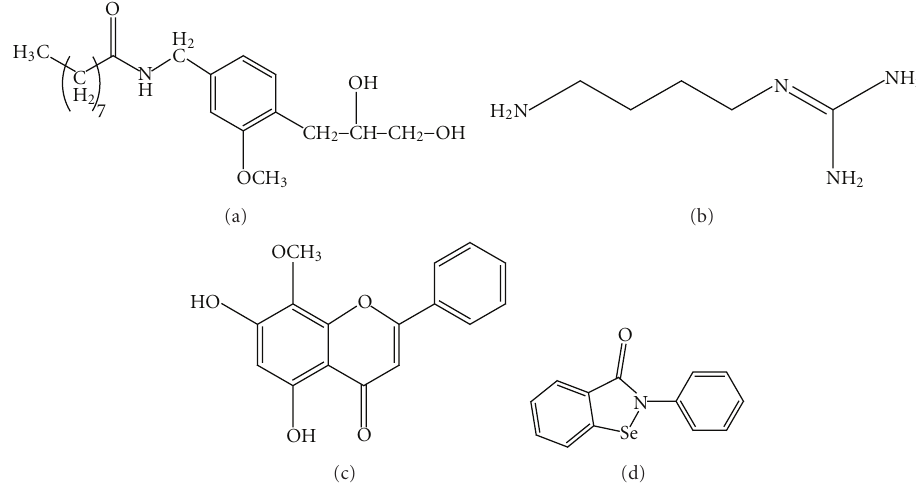
Figure 5: Chemical structure of glyceryl nonivamide (a), agmatine (b), wogonin (c), and ebselen